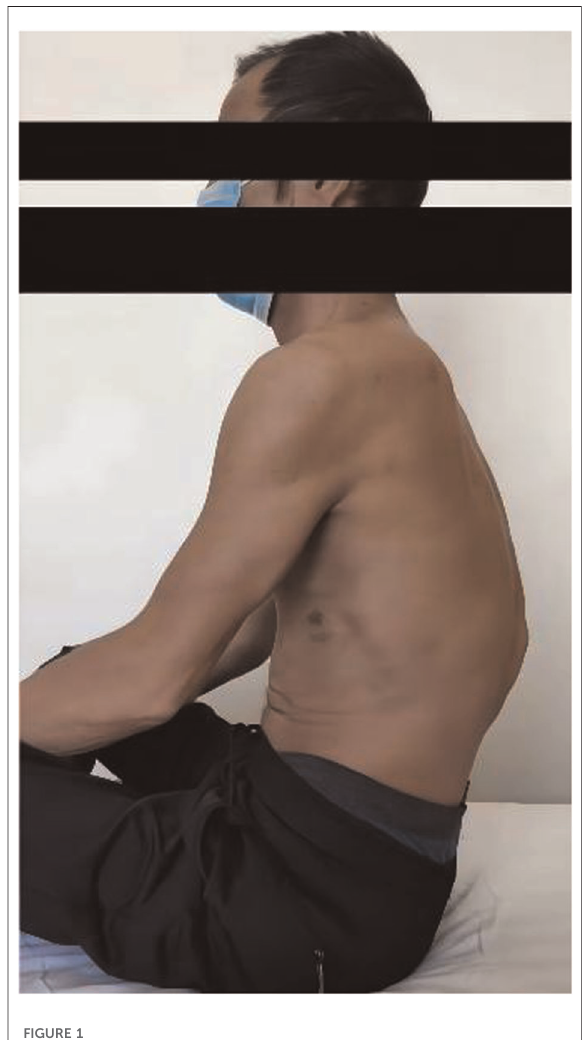
FIGURE 1 Pre-operative external observation.